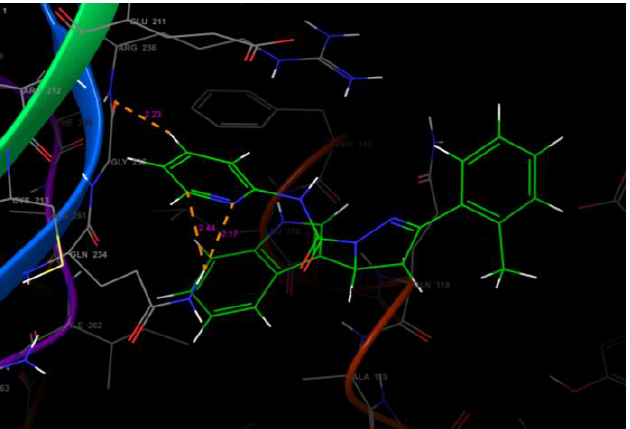
Figure 6. H-bonding interactions of compound after 4 d as visualized using pose viewer. Table 1. Docking results of the selected compounds.